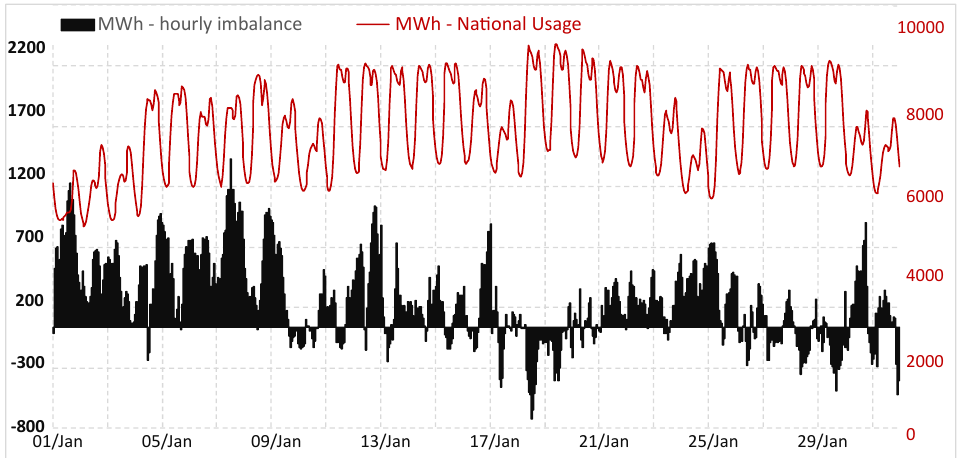
Figure 1. Romanian national hourly electricity